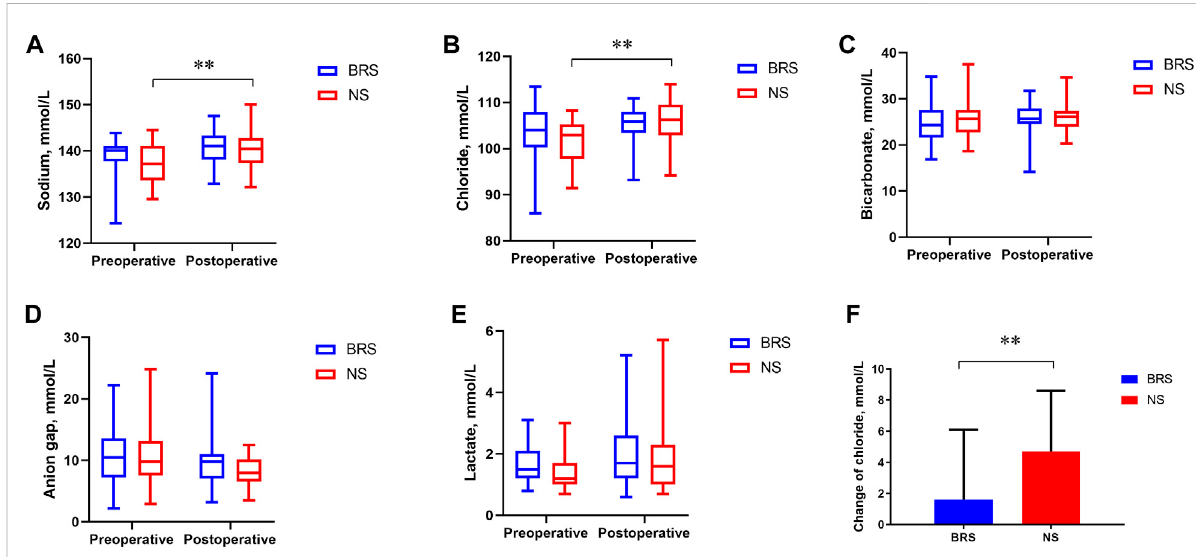
FIGURE 2 The concentrations of sodium, chloride, bicarbonate, anion gap, lactate and the change in the concentration of chloride preoperatively and postoperatively. The median and interquartile range of sodium (A) , chloride (B) , bicarbonate (C) , anion gap (D) , lactate (E) and the change in chloride (F) preoperatively and postoperatively are shown for the patients in each group. The concentration of preoperative sodium was lower than that of postoperative sodium in the NS group (137.2 vs. 140.4, p = 0.009). The concentration of preoperative chloride was lower than that